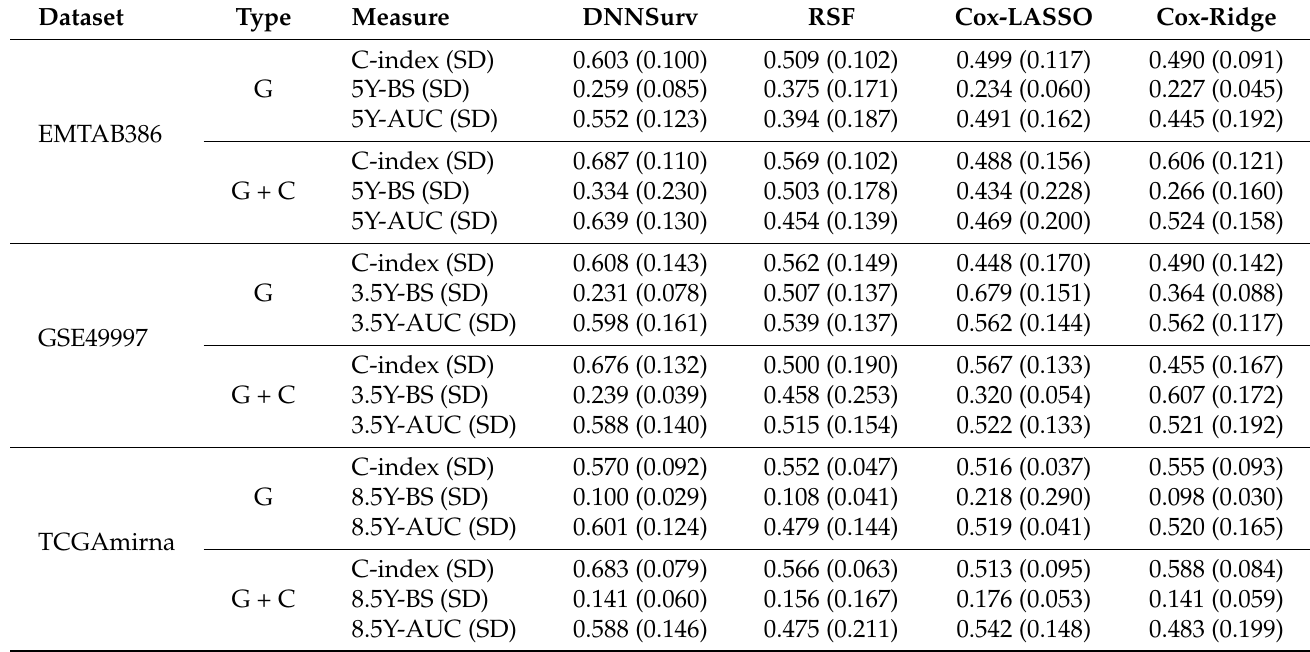
Table 3. The results (mean and SD) of the 10-fold CV C-index and the Brier score and AUC at the specified time point in the test data from four survival prediction models (DNNSurv, RSF, Cox-LASSO, and Cox-Ridge) for each